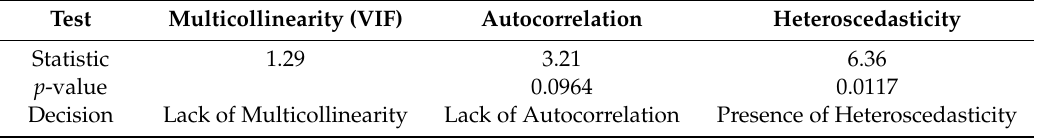
Table 11. Multicollinearity, serial autocorrelation in the error term, and heteroscedasticity.